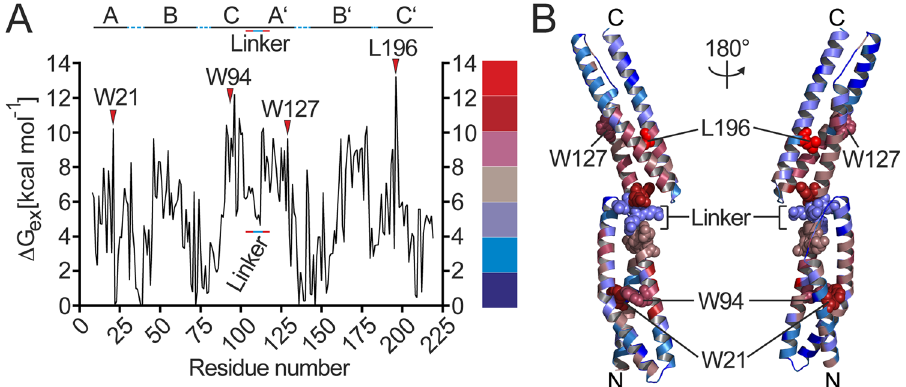
Figure 4. Stability fingerprint of R1617 determined by HR-HDXMS. ( A ) Plot of the free energy value Δ G ex for each amino acid residue of R1617. The linker region between repeats 16 and 17 and amino acids adjacent to the linker are indicated by solid blue and red lines, respectively. Amino acid residues exhibiting high stability are indicated. ( B ) The crystal structure of R1617 (PDB: 1CUN 23 ) colored according to the Δ G ex values shown in ( A